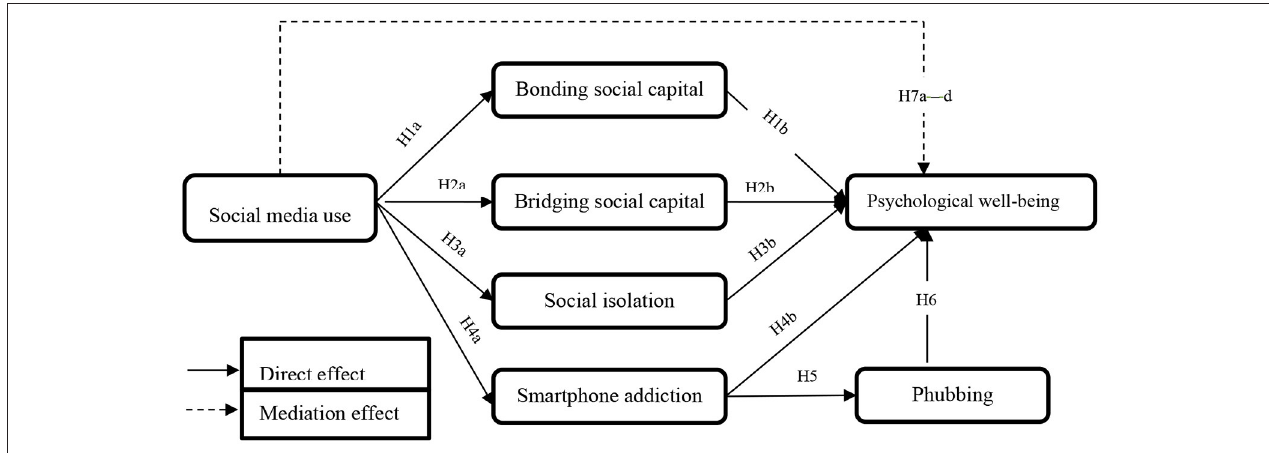
FIGURE 1 | Conceptual model.